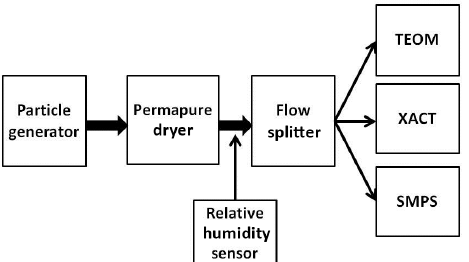
Figure 1. Schematic of instrument set up during laboratory calibra-